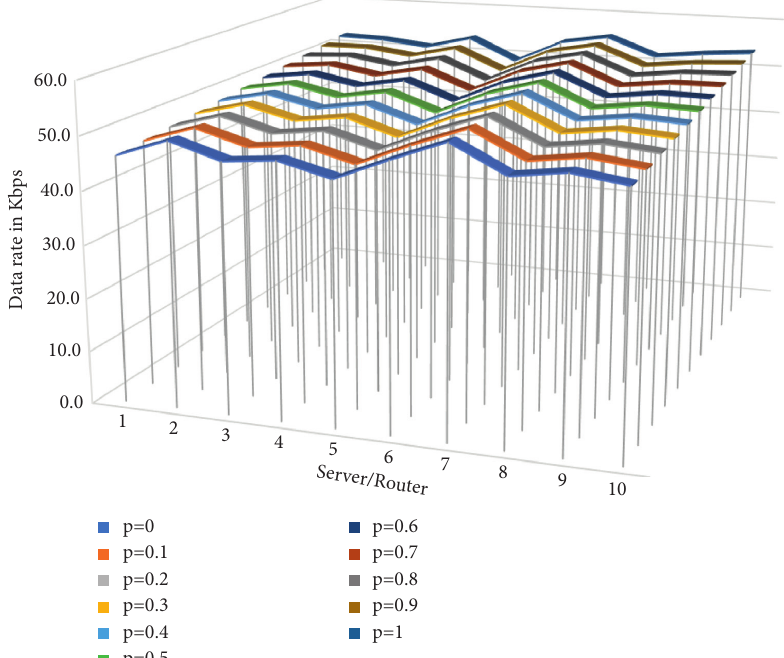
Figure 5: Graphical representation of data stream rate when α � 0 .